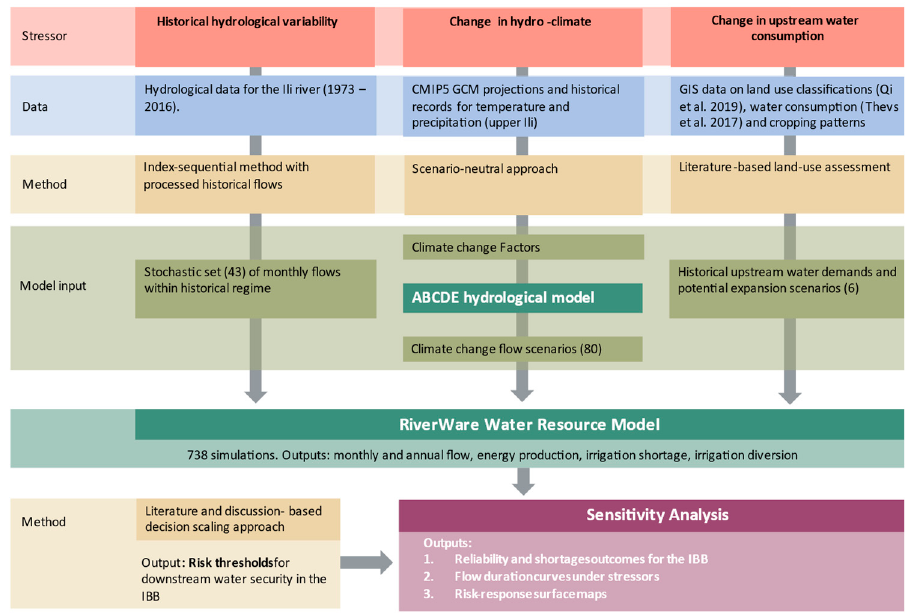
Figure 2. Graphical overview of methodology.